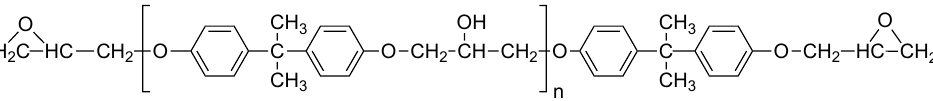
Figure 4. Structural formula of bisphenol-A diglycidyl